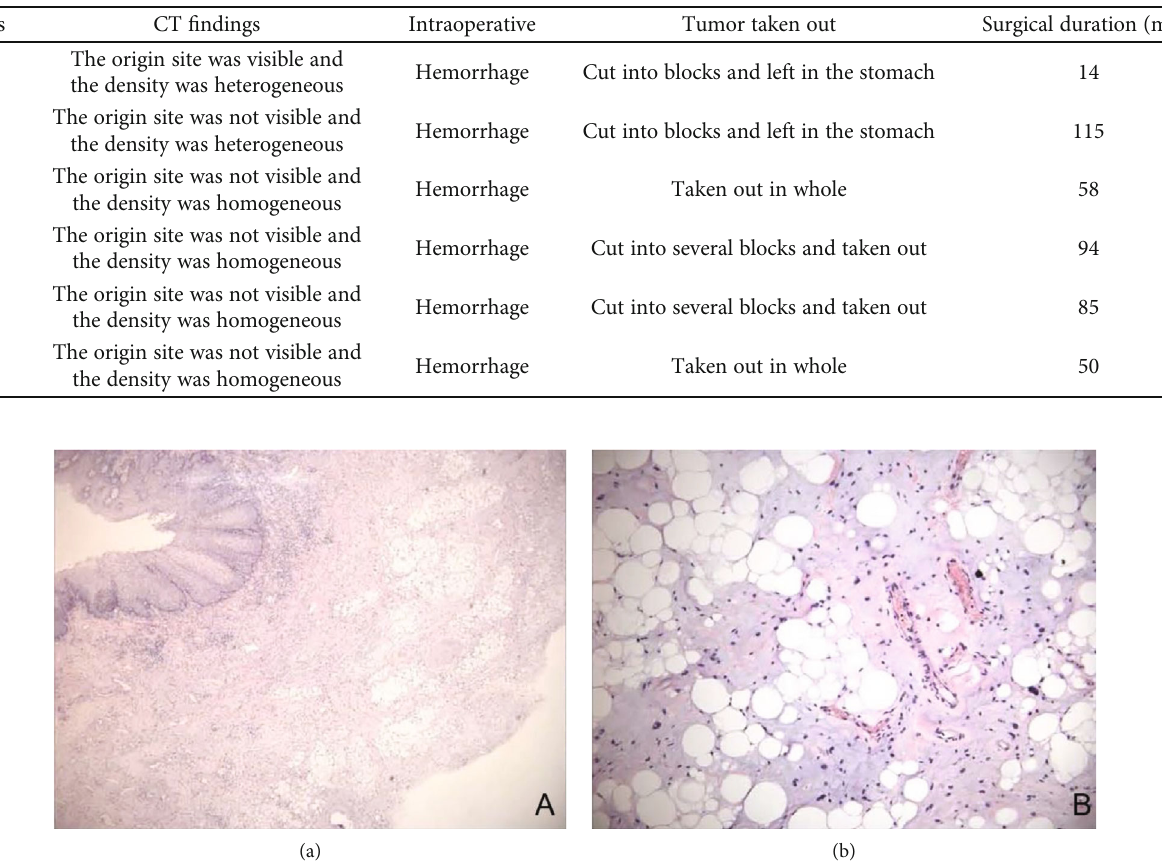
Figure 6: In addition to mature adipocytes, there are hyperplastic capillaries and endothelial cells in the tissue. Interstitial collagen fi bers were homogeneous, pale, and eosinophilic, with no obvious in fl ammatory